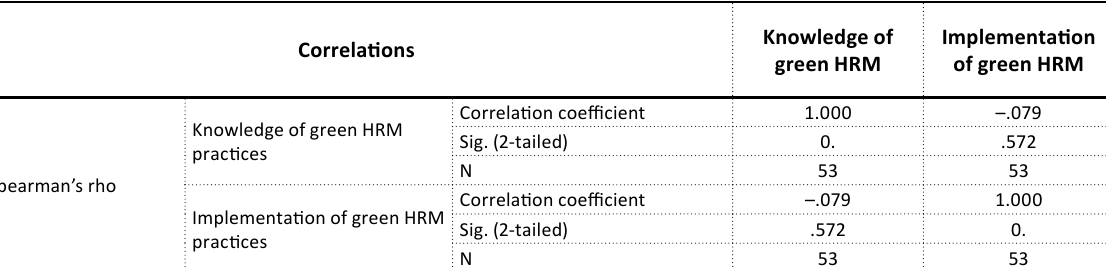
Table 3. Spearman’s correlation: knowledge of green HRM practices and implementation of green HRM practices.